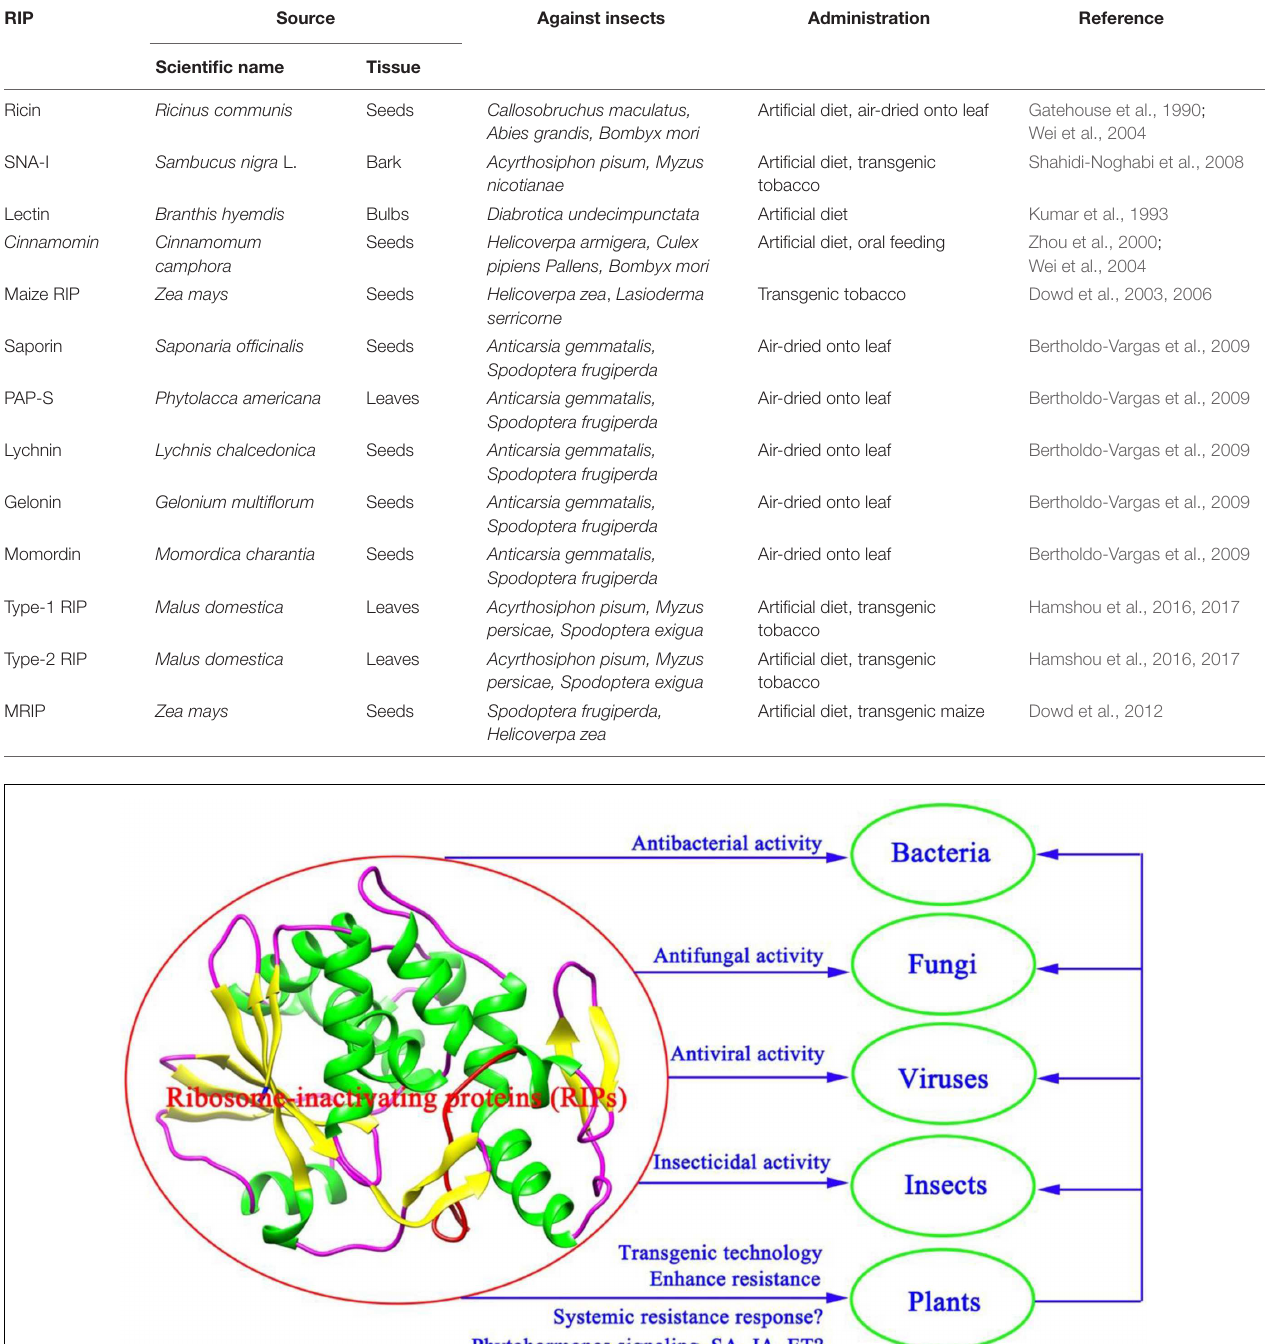
TABLE 6 | The Role of different source RIPs in defense against insects. RIP